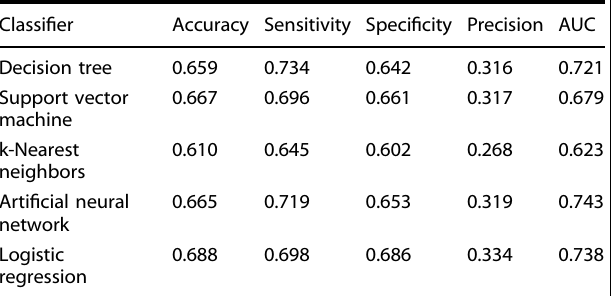
Table 2. Performance metrics of ML models for the 90-day readmission